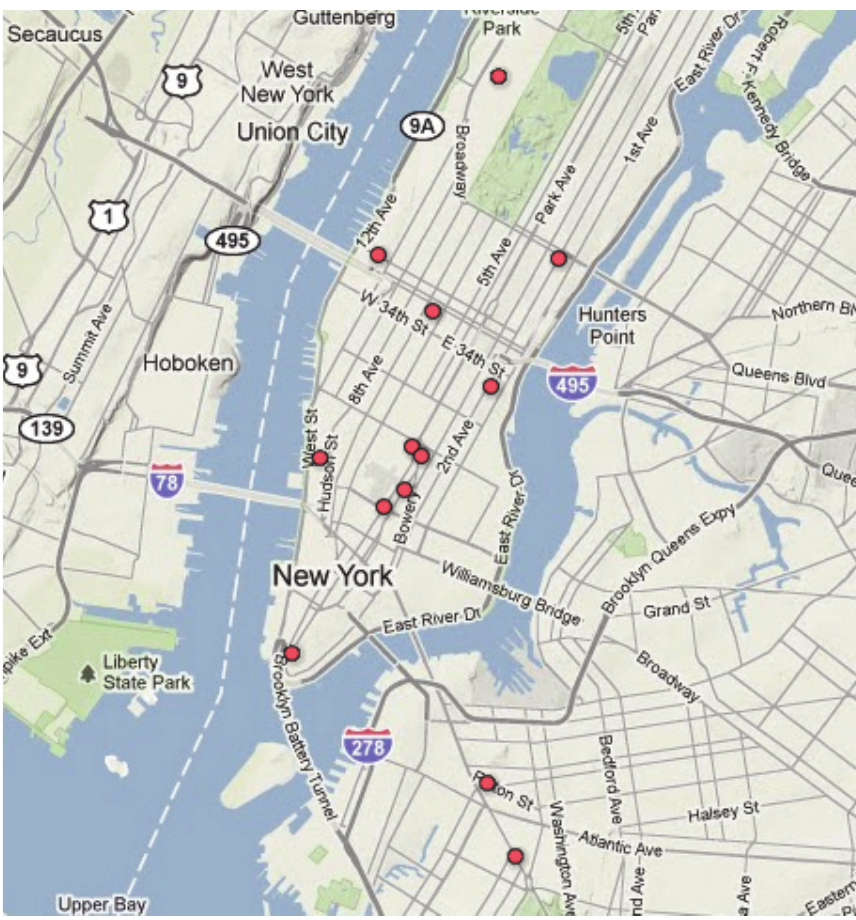
<Figure 1> Locations of Crunch Gym in